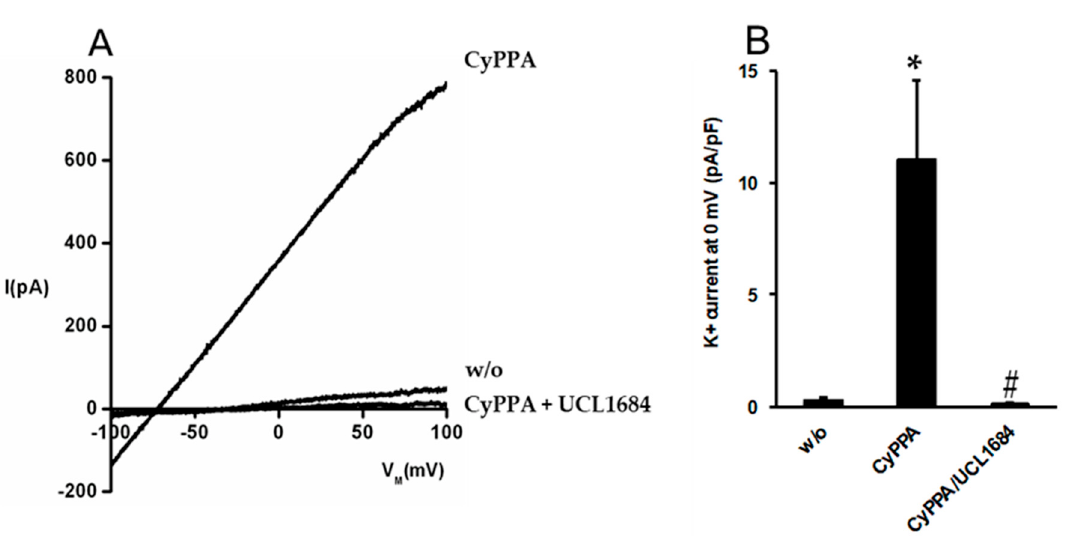
Figure 3. Activation of SKCa currents in porcine arterial endothelial cells by CyPPA. ( A ) Representative whole-cell currents in the absence (w / o) and in the presence of CyPPA (10 µ M) as well as inhibition of the CyPPA-activated currents by the SKCa blocker, UCL-1684 (1 µ M). ( B ) Average data are given as means ± S.E.M. (CyPPA, n = 4; UCl1684, n = 3); * p < 0.05 vs . w / o; # p < 0.05 vs . CyPPA.